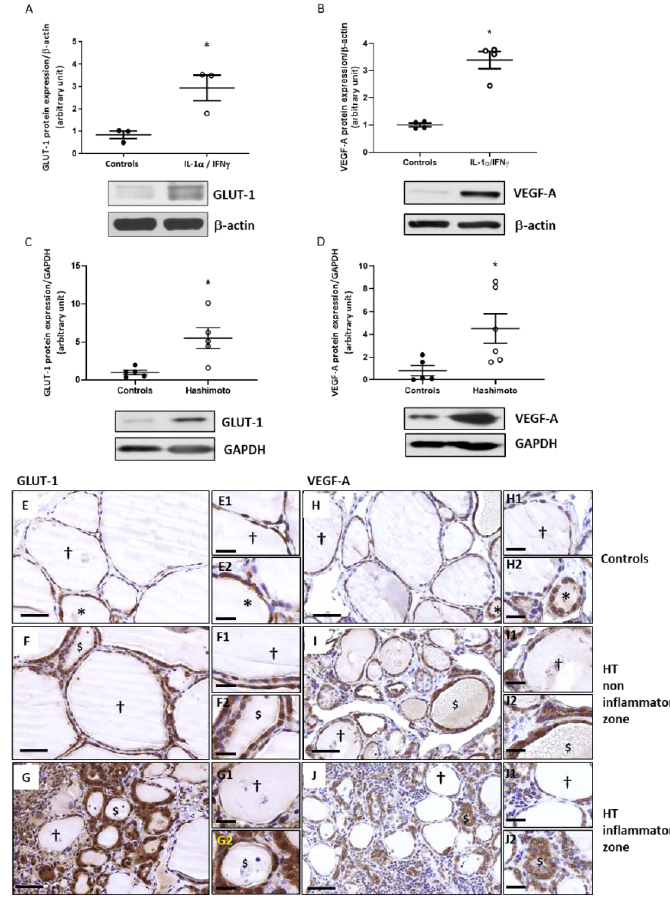
Figure 6. GLUT-1 and VEGF-A expressions were increased in Th1-HT context. GLUT-1 and VEGF-A protein expressions were quantified using Western blot technique. Significantly increased GLUT-1 was observed in thyroid cells treated with Th1 cytokines ( A ). Similar result was obtained for VEGF-A protein ( B ). Densitometric values were normalized against β-actin level. Results are expressed as means ± SEM from three (GLUT-1) and four (VEGF-A) experiments ( n = 3–4) at least in duplicate. GLUT-1 was highly increased in HT patients compared to controls ( C ). A significant increase of VEGF- A protein expression was also observed in HT thyroids compared to controls ( D ). Densitometric values were normalized against the GAPDH level. Results are expressed as means ± SEM from five or six individual samples ( n = 5–6). * p < 0.05 compared to controls. Representative blots are shown. Faint GLUT-1 immunolabelling was detected in control thyroids ( E ) and the staining was more pronounced in active follicles (*). In non-inflammatory zones of HT thyroids, thyrocytes of altered active-like follicles ($) and hypofunctional follicles (†) showed considerable, diffuse, and cytoplasmic staining of GLUT-1 ( F ). In inflammatory zones, GLUT-1 expression was still more pronounced in active-like follicles ($) ( G ). In control thyroids ( H ), VEGF-A staining was low in hypofunctional follicles (†) and was moderate in active follicles (*). Both hypofunctional (†) and altered active- like follicles ($) in non-inflammatory zone ( I ) and inflammatory zone ( J ) of HT thyroids strongly expressed VEGF-A protein. Images show representative samples. ( E – J ) Scale bar = 50 µ m. ( E1 – J2 ) Scale bar = 20 µ